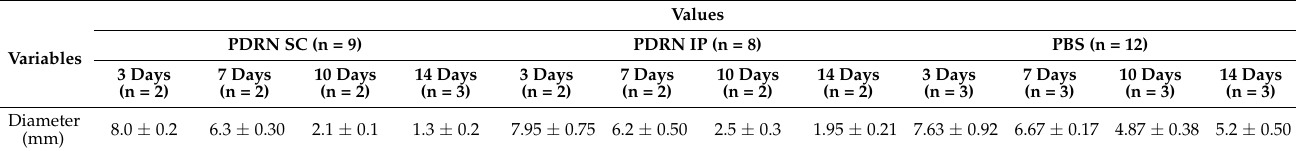
Figure 2. Time-dependent changes in the diameter of diabetic wounds at 3, 7, 10 and 14 days. At 10 days, the PDRN SC group showed a significantly smaller diameter of diabetic wounds as compared with the PBS group (2.1 ± 0.1 versus 4.87 ± 0.38 mm, respectively; p = 0.0024). Likewise, the PDRN IP group also showed a significantly smaller diameter of diabetic wounds as compared with the PBS group (2.5 ± 0.3 versus 4.87 ± 0.38 mm, respectively; p = 0.0053). At 14 days, the PDRN SC group showed a significantly smaller diameter of diabetic wounds as compared with the PBS group (1.3 ± 0.2 versus 5.2 ± 0.50 mm, respectively; p = 0.0002). Likewise, the PDRN IP group also showed a significantly smaller diameter of diabetic wounds as compared with the PBS group (1.95 ± 0.21 versus 5.2 ± 0.50 mm, respectively; p =0.0036).